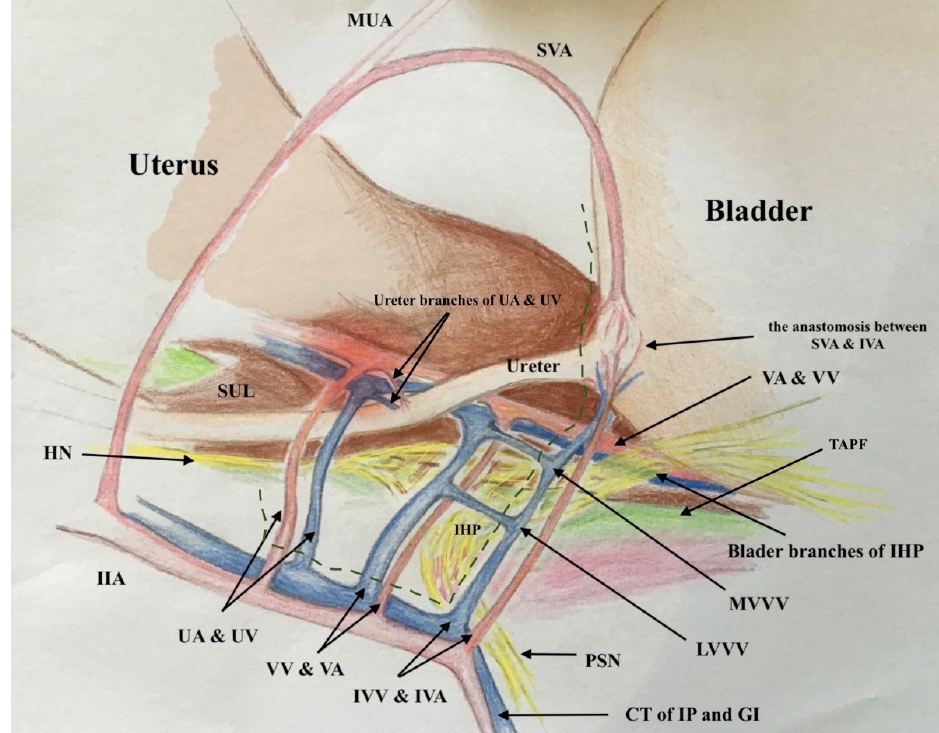
Figure 9. The graphic explanation of the type IV radical hysterectomy according to Muallem classi- fication; the dotted green line shows the resection line at the distal aspects of ventral, lateral and dorsal parametrium and at the distal aspects of ventral, lateral and dorsal paracolpium.